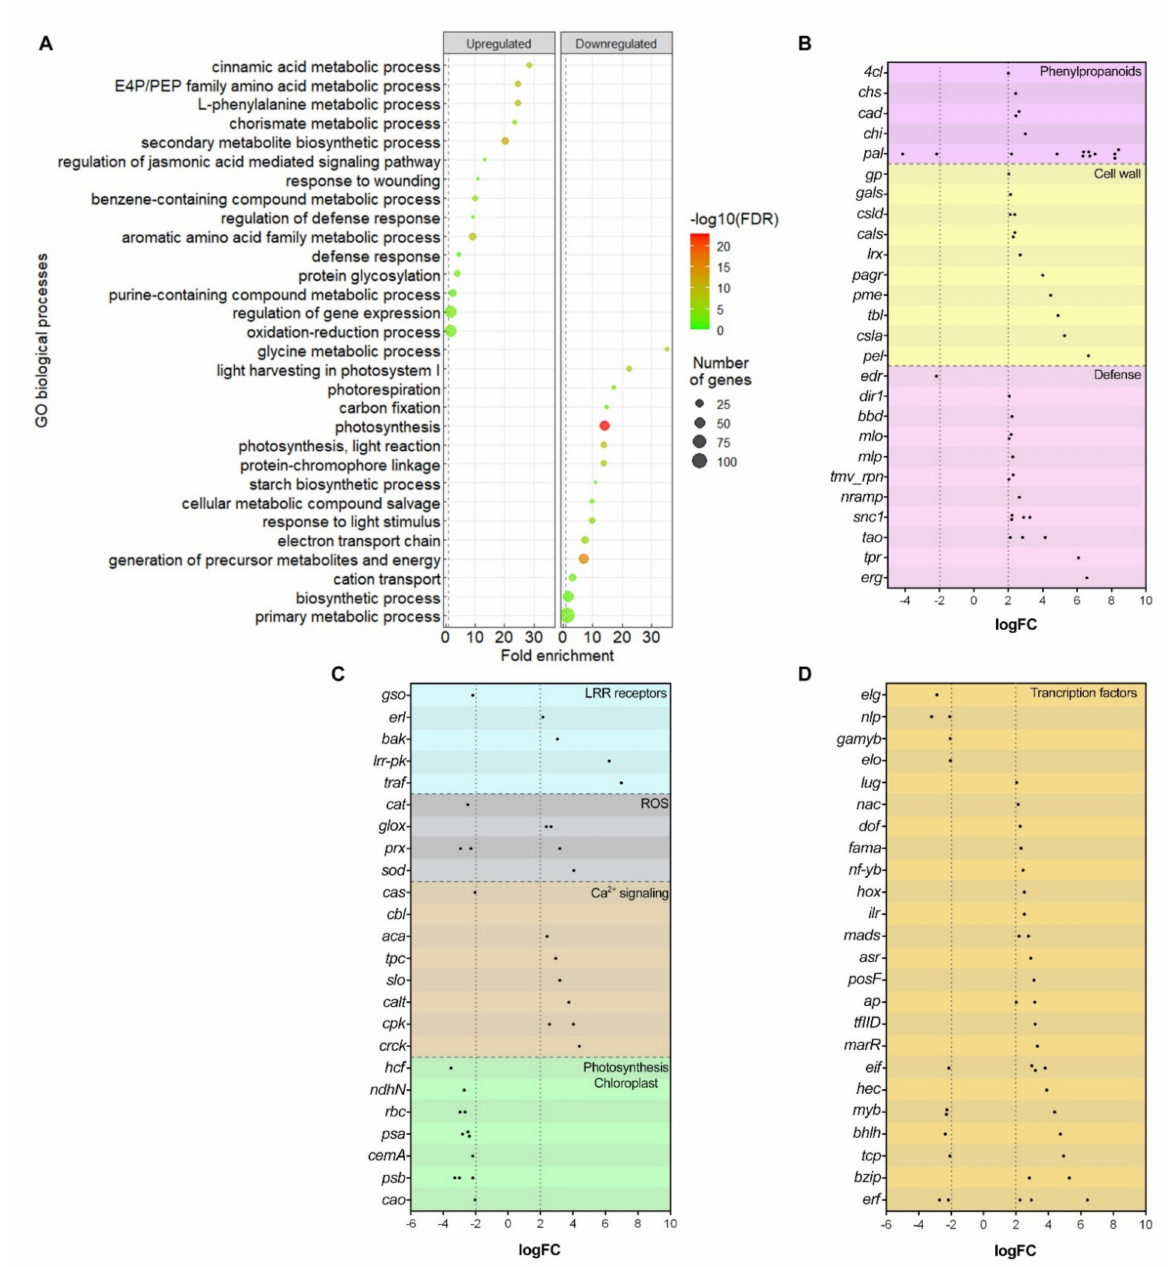
Figure 4. Enriched biological processes and their genes. ( A ) Gene ontology enrichment analysis of differentially expressed genes in P. patens . The most significant biological processes are represented and ordered according to their enrichment. The dot size indicates the number of differentially expressed genes associated with the process, function or component and the dot color indicates the significance of the enrichment ( − log 10 FDR). The vertical grey dashed line represents a fold enrichment of 1. E4P: erythrose 4-phosphate; PEP: Phosphoenolpyruvate. ( B ) Differential expression of genes corresponding to phenylpropanoids, cell wall reinforcement and defense biological processes. 4cll : 4-Coumarate-CoA ligase ; chs : Chalcone synthase ; cad : Cinnamyl alcohol dehydrogenase ; chi : Chalcone-flavonone isomerase ; pal : Phenylalanine ammonia-lyase ; gp : Vegetative cell wall protein gp1 ; gals : Galactan beta-1,4-galactosyltransferase ; csld : Cellulose synthase ; cals : Callose synthase ; lrx : Leucine-rich repeat extensin-like protein ; pagr : Protein pectic arabinogalactan synthesis-related ; pme : Pectinesterase ; tbl : Protein trichome birefringence ; csla : beta-Mannosyltransferase ; pel: Pectate lyase ; edr : Protein Enhanced Disease Resistance ; dir1 : Putative lipid-transfer protein DIR1 ; bbd : bifunctional nuclease 1-like ; mlo : MLO-like protein ; mlp : MLP-like protein ; tmv_rpn : TMV resistance protein N-like ; nramp : Nramp-domain-containing protein ; snc1 : Protein suppressor of NPR1-1, constitutive 1 ; tao : Disease resistance protein TAO1 ; tpr : Topless-related protein ; erg : Elicitor-responsive protein ; gso :